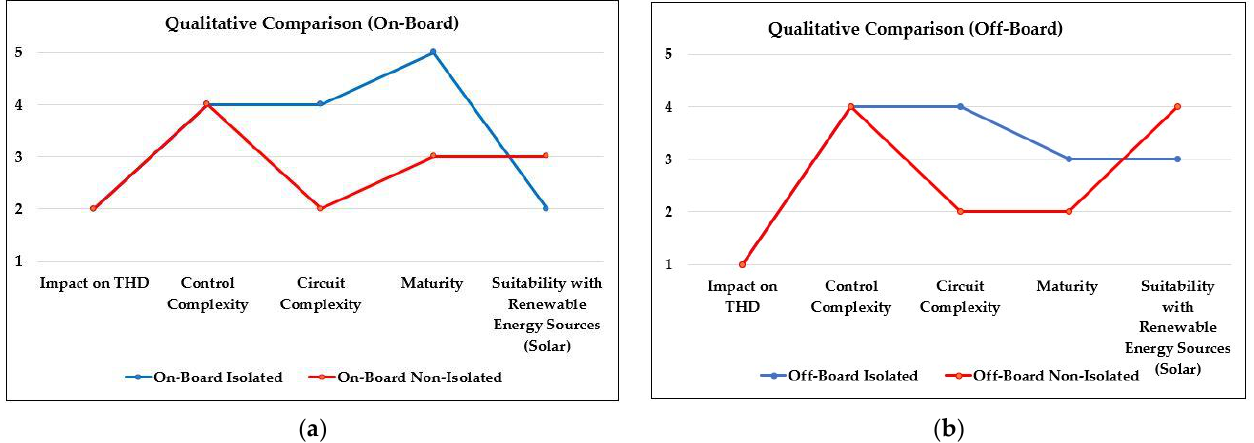
Figure 21. Qualitative comparison of ( a ) On-Board and ( b ) Off-Board DC-DC converters. On a scale of 1 to 5, 1 = lowest and 5 = highest.